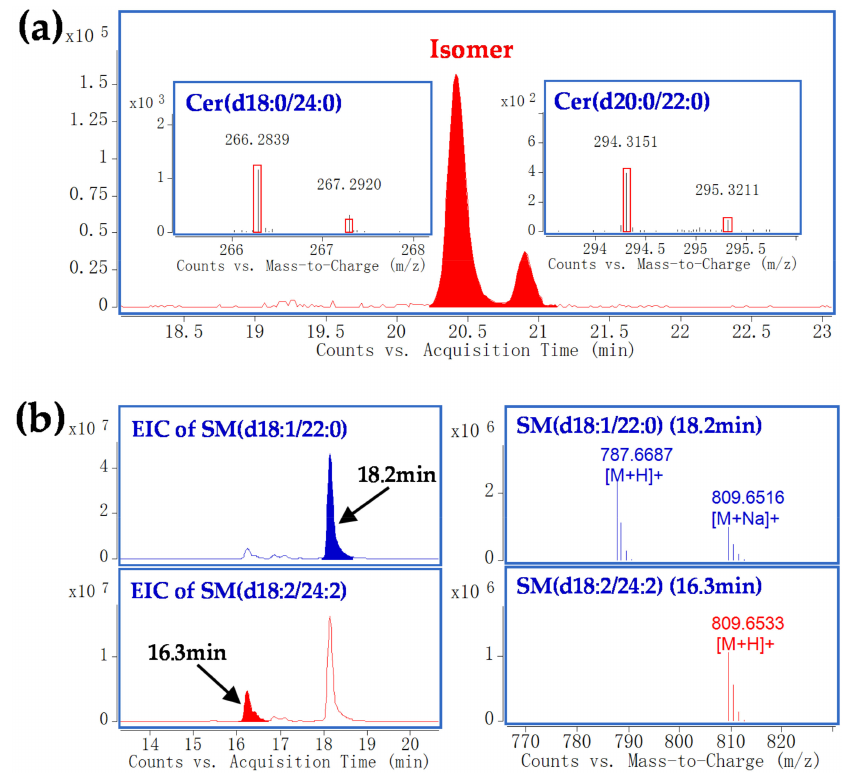
Figure 3. ( a ) Differentiation of SPL isomers by targeted-MS/MS analysis. Two peaks in EIC of m / z 652.6602 showed characteristic fragment ion corresponding to Cer (d18:0/24:0) ( m / z 266.2839) and Cer (d20:0/22:0) ( m / z 294.3151); ( b ) Differentiation of [M + H] + of SM (d18:2/24:2) and [M + Na] + of SM (d18:1/22:0) that with the same exact m / z . The “real” [M + H] + of SM (d18:2/24:2) was assigned by the observation of its corresponding [M + Na] + ion. Cer, ceramide; SM,